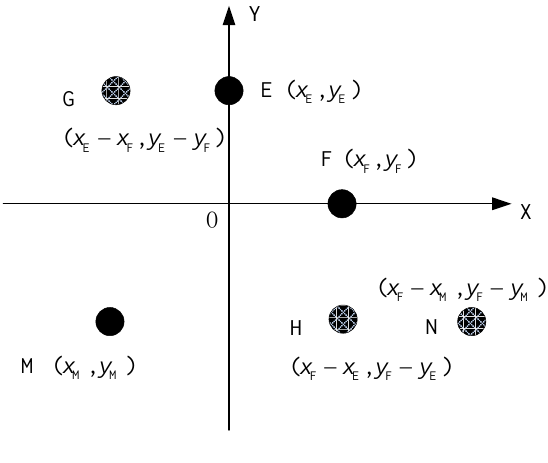
Figure 7. Positions of the virtual elements. The black points represent the actual element (E, F and M); and the shadow points represent the virtual elements(G, H and